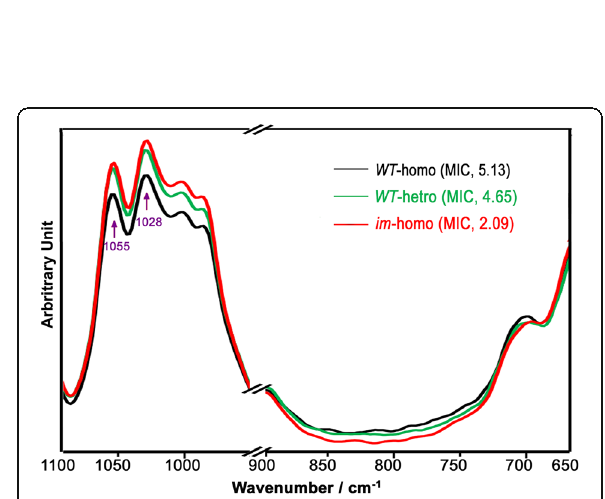
Fig. 4 Representative of normalized ATR FT-IR spectra of three F 2 progeny cotton plants with MIC values of 5.13, 4.65, and 2.09. The three F 2 plants were selected from the different genotype plants (WT-homo, WT-hetro, and im -homo) shown in Fig. 1b. Each spectrum shown in the graph was normalized by dividing the intensity of individual vibration with the average intensity. Two wavenumbers (1055cm − 1 and 1020cm − 1 ) showing differences in the intensities among the cotton fibers were marked with purple arrows